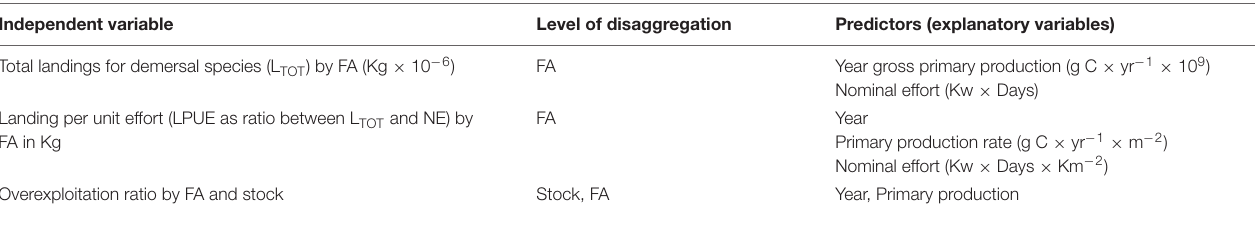
TABLE 2 | List of predictors (regressors) used for the GAMs. Independent variable Level of disaggregation Predictors (explanatory